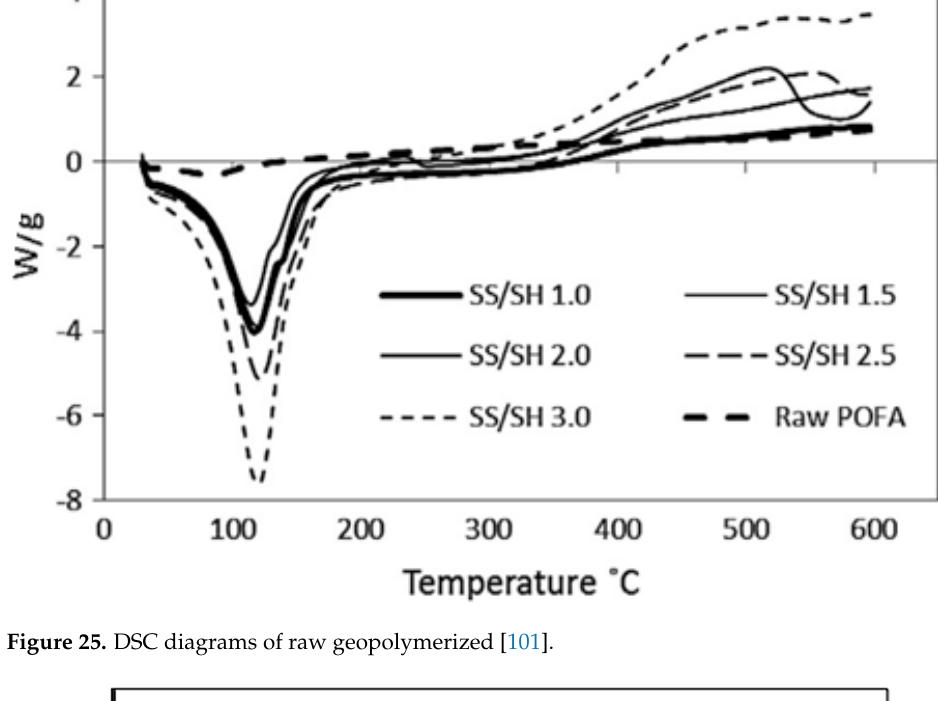
Figure 25. DSC diagrams of raw geopolymerized [101].